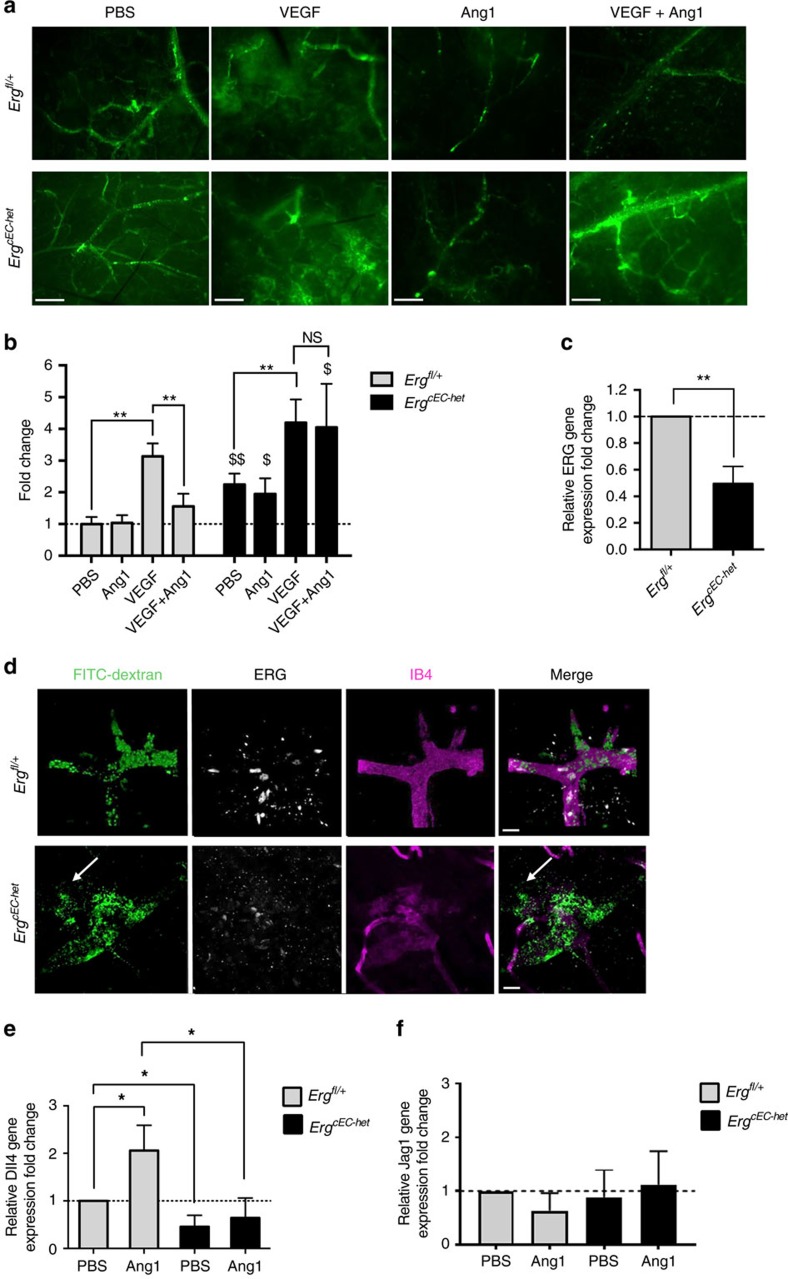
Ang1 requires ERG to promote vascular stability and drive Dll4 expression in vivo.(a) Ergfl/+ and ErgcEC-het mice were subdermally injected with PBS, VEGF, Ang1, or a combination of reagents (Ang1+VEGF) (50 ng in 50 μl) for 1 h. Mice received intravenous injection of FITC-dextran 15 min before collecting skin samples. Representative images of whole-mount skin samples perfused with FITC-dextran (green). (b) Vessel permeability was quantified by measuring the intensity of FITC-dextran per field (n=5 fields per mouse, n=3 mice per genotype). The average of the mean intensity per mouse was converted to fold change compared to Ergfl/+ mice injected with PBS. (c) qPCR analysis of ERG expression in extracts of skin samples from control Ergfl/+ and ERG hemi-deficient (ErgcEC-het) mice (n=3). (d) Representative images of corresponding skin samples showing extravasation of FITC-dextran (green) from blood vessels stained for isolectin B4 (IB4, purple). qPCR analysis of (e) Dll4 and (f) Jag1 expression in extracts of skin samples from control Ergfl/+ and ERG hemi-deficient (ErgcEC-het) mice treated with intradermal injection of PBS or Ang1 for 1 h (n=3). All graphical data are mean±s.e.m., *P<0.05, **P<0.01, ***P<0.001, Student’s t-test. $: ErgcEC-het mice compared to Ergfl/+ mice for each treatment, $ P<0.05, $$ P<0.01, $$$ P<0.001, Student’s t-test.